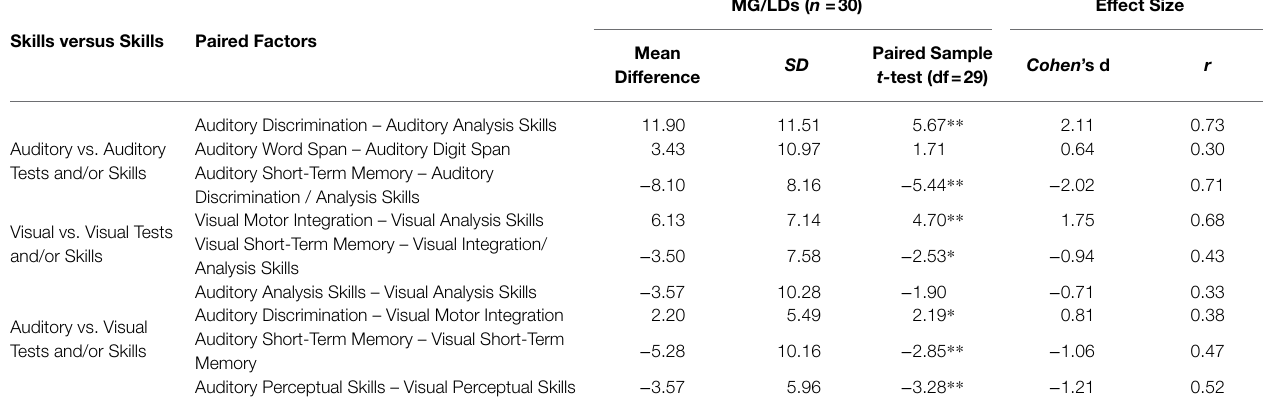
TABLE 3 | Perceptual skills for the MGLDs/2E students.